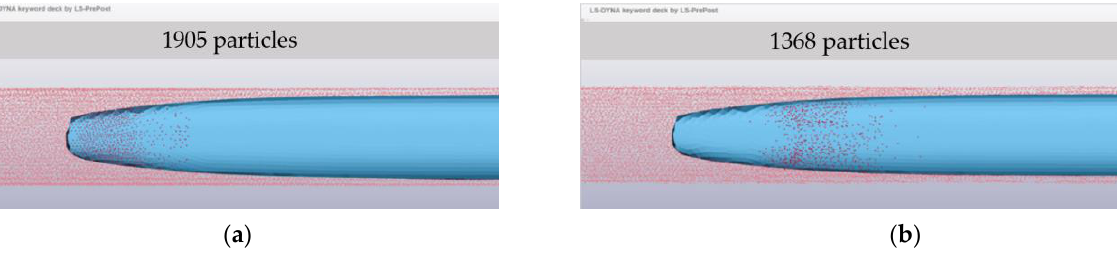
Figure 11. These are the two working conditions of Scenario 3: ( a ) conditions in the sixth-level sea state when waves hit the hull, and ( b ) conditions when the sixth- level sea state’s sea spray